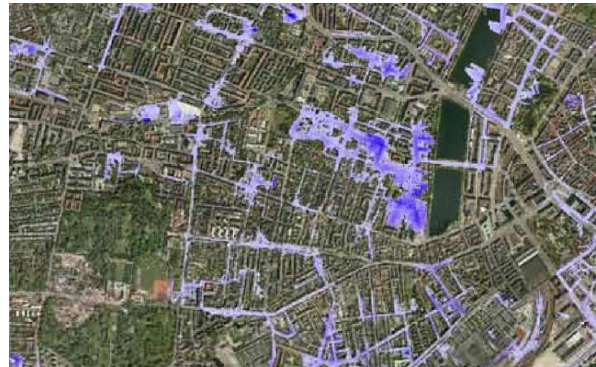
Figure 3 . Example of city cloudburst flood as simulated by 2D model